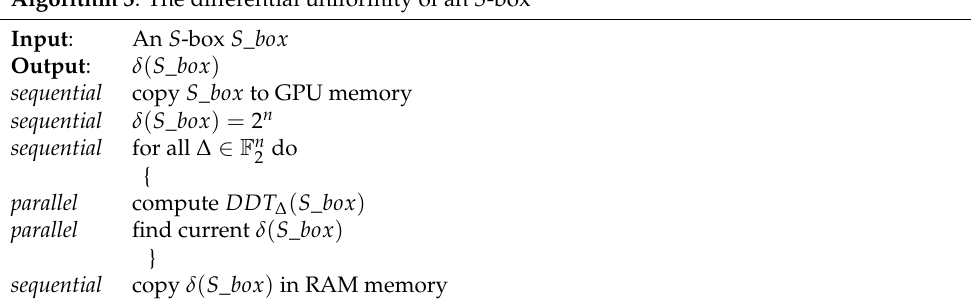
Algorithm 3 : The differential uniformity of an S